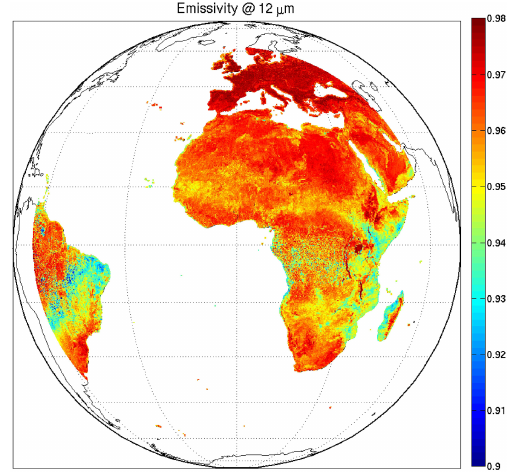
Figure 20. November 2007 map of channel emissivity at 10.8µm over the SEVIRI full disk.